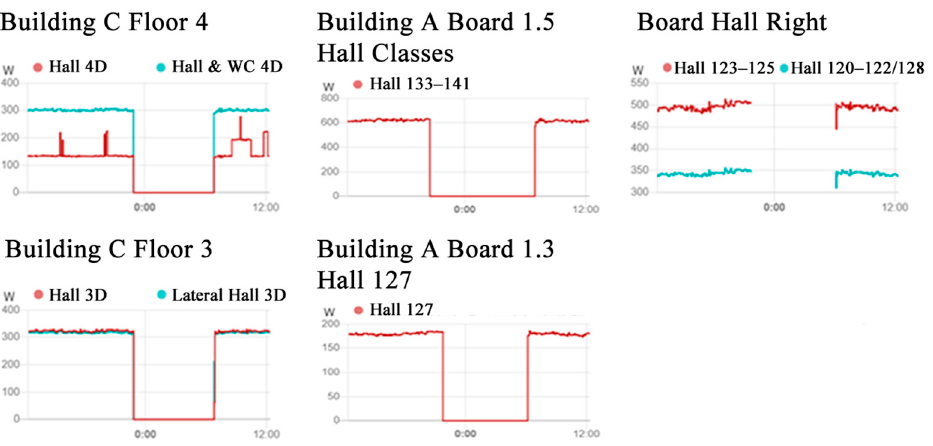
Figure 14. Demand profiles presented by the home assistant.